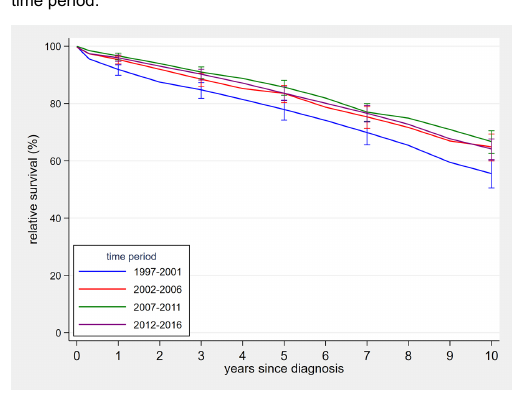
Figure S1: Age-standardised relative survival curves of chronic lymphocytic leukaemia / small lymphocytic lymphoma patients by time period.